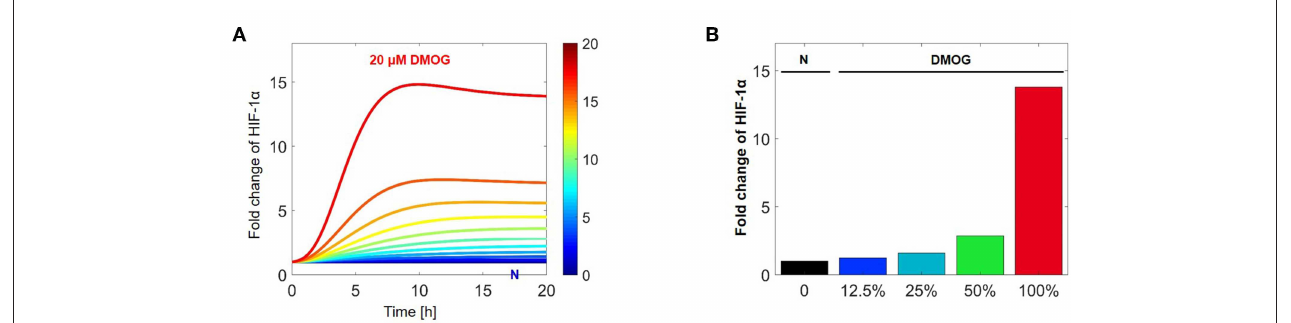
FIGURE 11 | Stabilization of HIF-1 α in dependence on DMOG concentration after IL-15 stimulation. (A) Evolution of HIF-1 α in time, depending on the DMOG dosage with dark blue corresponding to no DMOG (N) and red corresponding to 20 µ M DMOG. In these simulations cells are initially stimulated with IL-15. (B) Fold change of HIF-1 α stabilization at the equilibrium ( t = 100 h). Simulation of NK cell treatment with increasing concentrations of DMOG. Parameter values for these simulations are chosen as in Tables 1 , 2 , with 100% corresponding to 20 µ M DMOG.